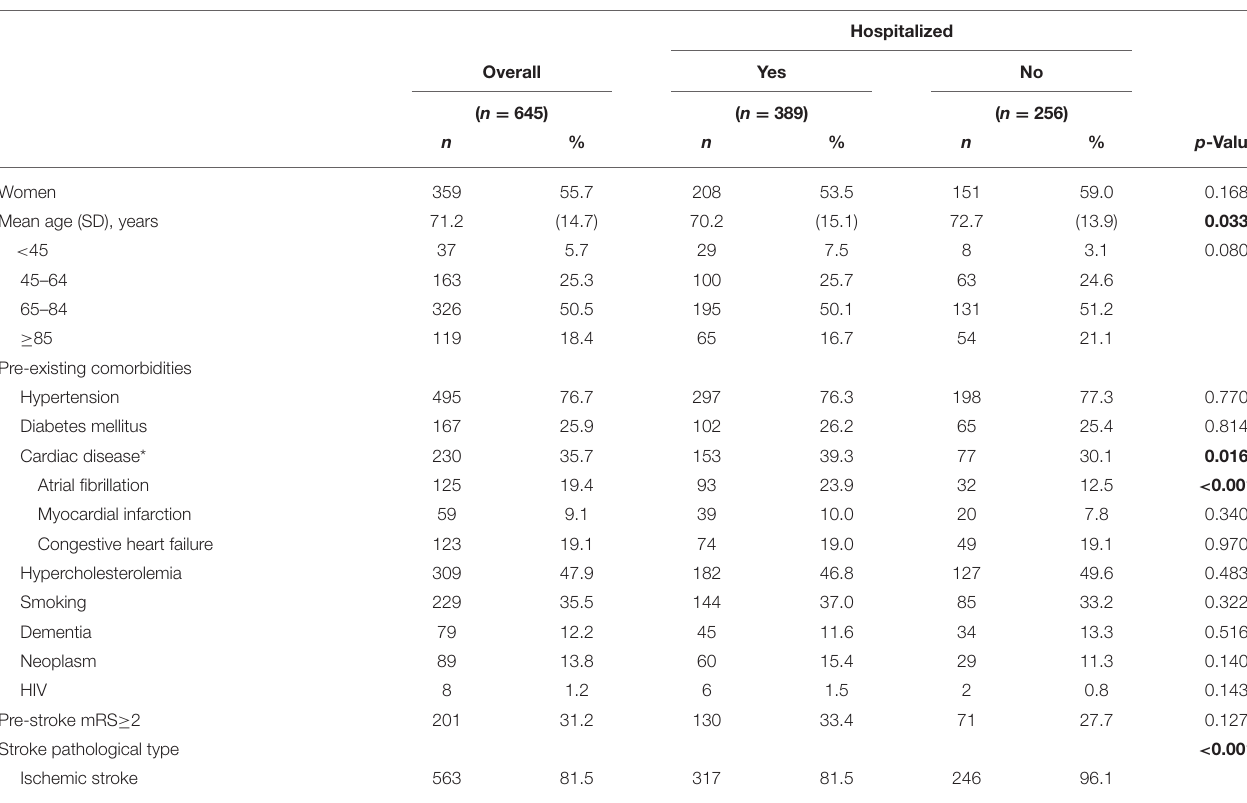
TABLE 2 | Baseline characteristics of first-ever-in-a-lifetime stroke patients in risk of